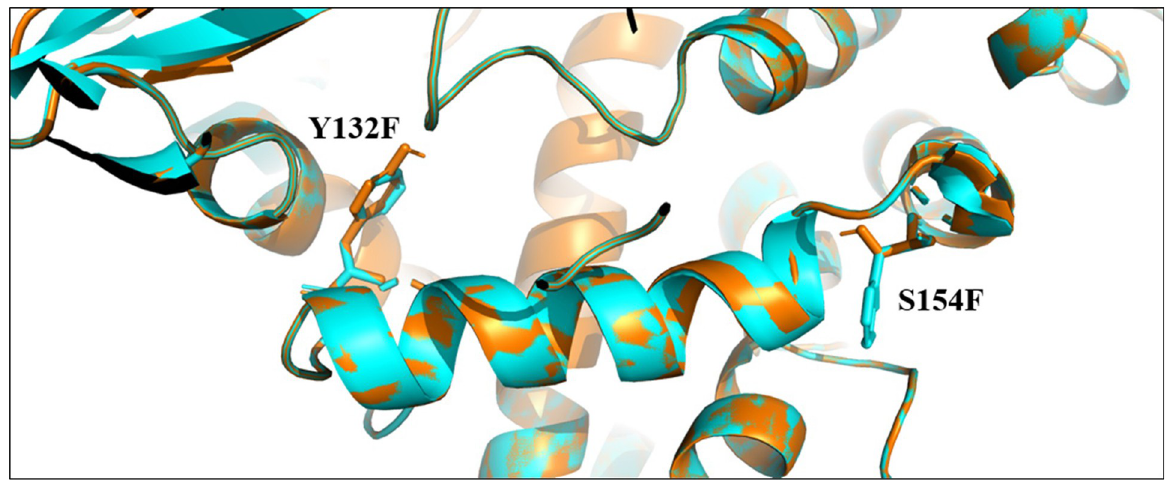
Fig 3. Homology modelling of ERG11p. Structural superimposition of both wild and mutant type. Wild type is colored in orange and mutant is in cyan. Mutated residues are shown in stick representation and labelled accordingly.